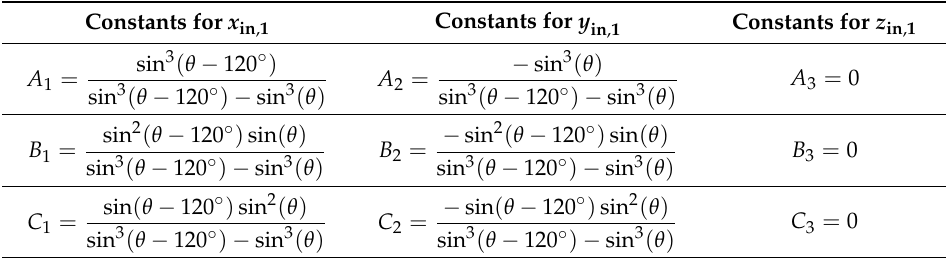
Table 1. Value of constants when 0 ◦ < θ < 120 ◦